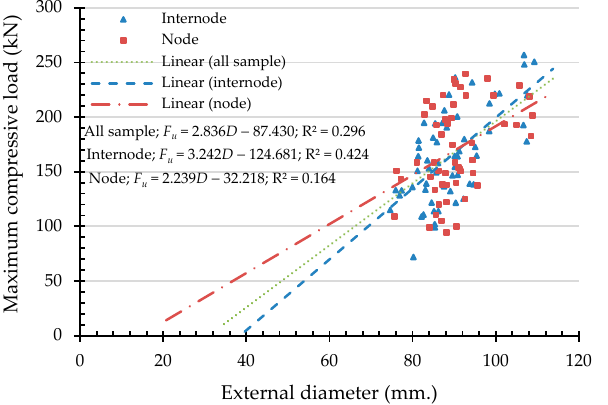
Figure 13. The simple linear regression analysis of bamboo maximum compressive load ( F u ) with external diameter as an indicating property.